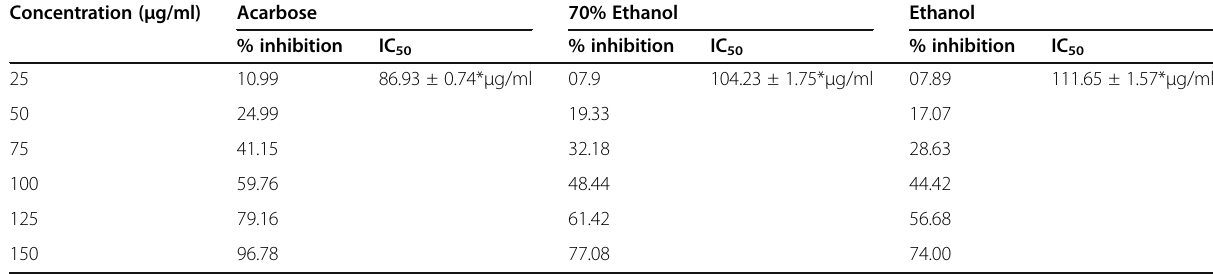
Table 3 α -glucosidase enzyme inhibition (%) by MZFP extracts Concentration ( μ